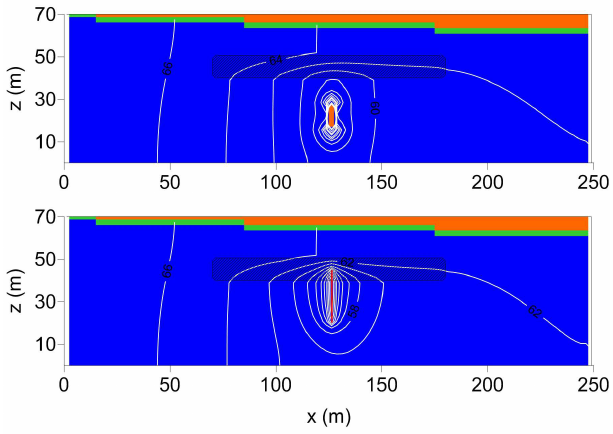
Figure 3. Contour lines of the hydraulic head (2-meter contour interval) and map of the saturation field (fully-saturated cells are drawn in blue; partially-saturated cells are drawn in green; dry cells